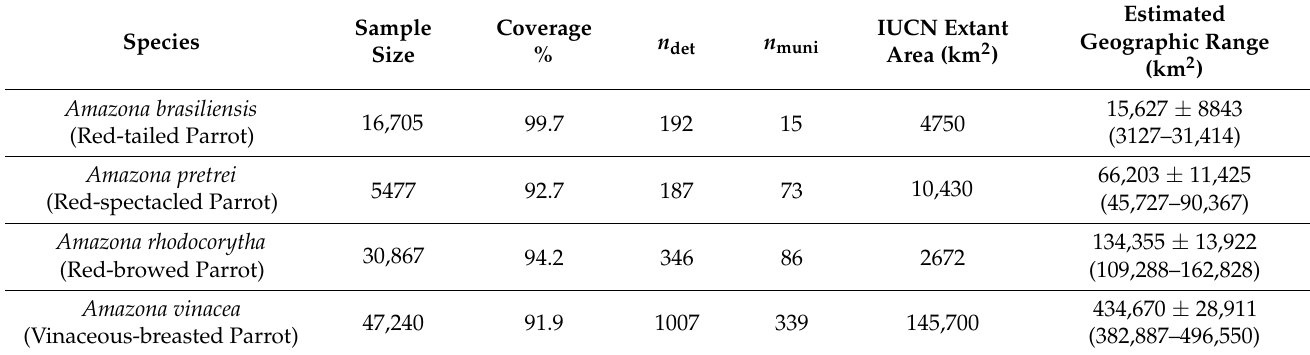
Table 1. Sample size, spatial coverage, and number of detections for the four parrot species. Sample size is the number of samples collected form the citizen-science and research datasets, as defined in the text. Coverage is the proportion of municipalities in each study area with at least one sample. The labels n det and n muni show, respectively, the number of parrot detections and the number of municipalities with at least one detection. The last two columns show geographic ranges sizes: the IUCN Extant area is given in each species’ online entry to the IUCN Red List of Threatened Species. The estimated geographic range is the sum of municipality areas weighted by the estimated probability the species occurred in each municipality (given here by the mean ± standard deviation of the a posteriori distribution of range size, followed by its 95% credible interval (in parentheses)).